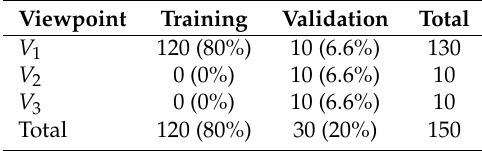
Table 2. Distribution of images across training and testing sets for V 1 , V 2 and V 3